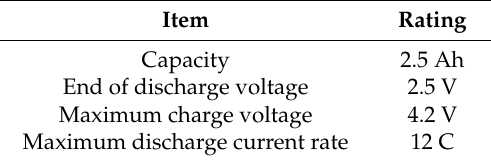
Figure 3. Schematic diagram of the battery test bench. Table 1. Characteristics of Sony US18650VTC5a cell.